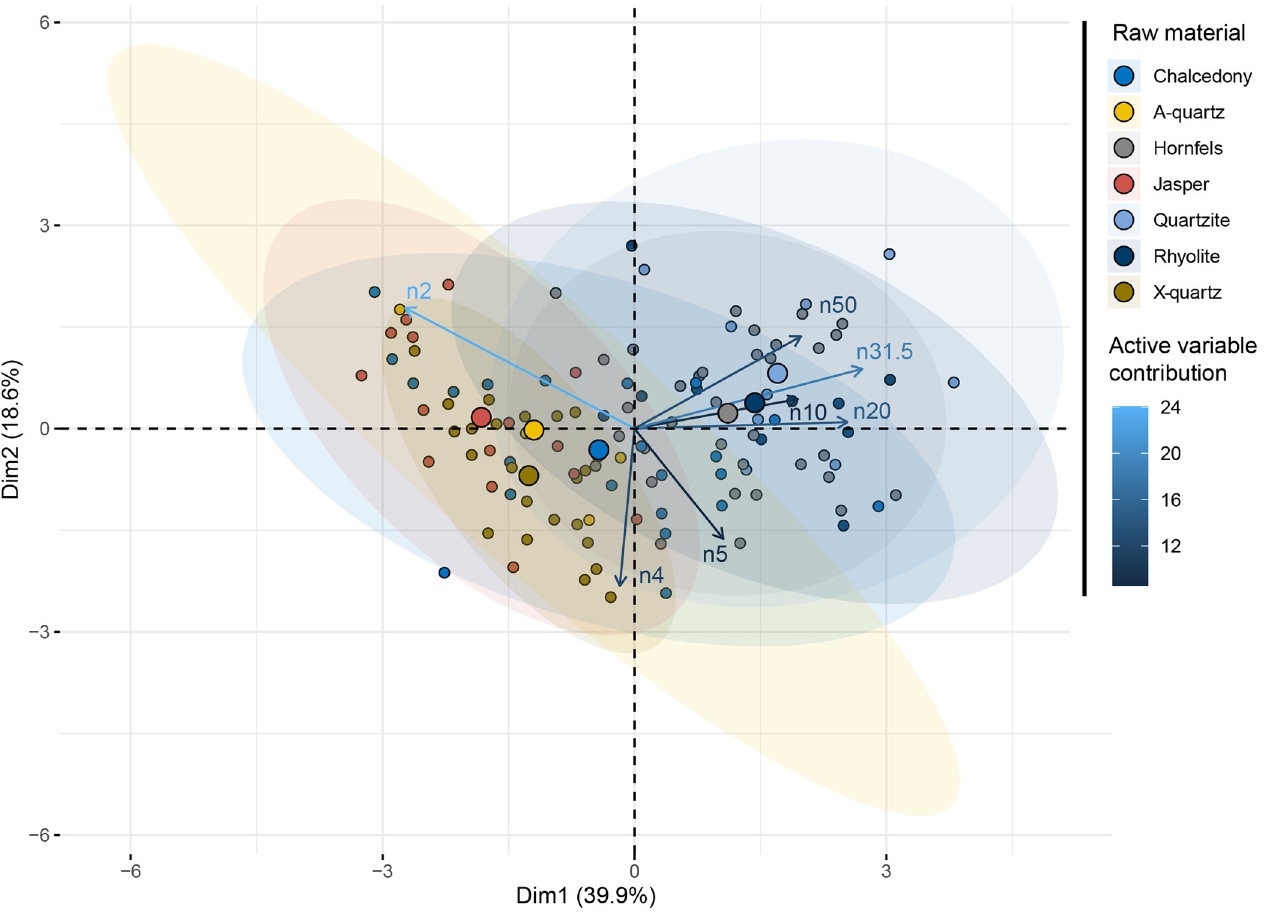
Fig 10. PCA of the SA dataset with the raw material as a supplementary variable.